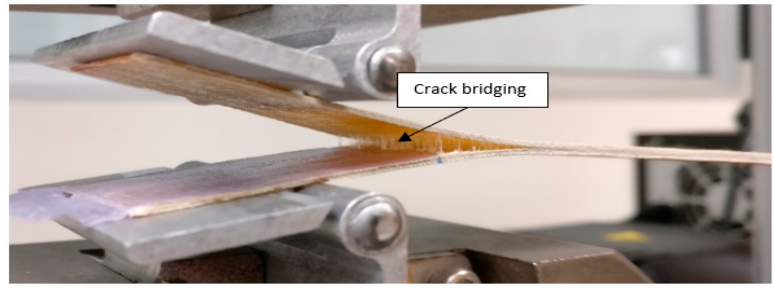
Figure 12. Crack bridging during DCB test in Mode I.